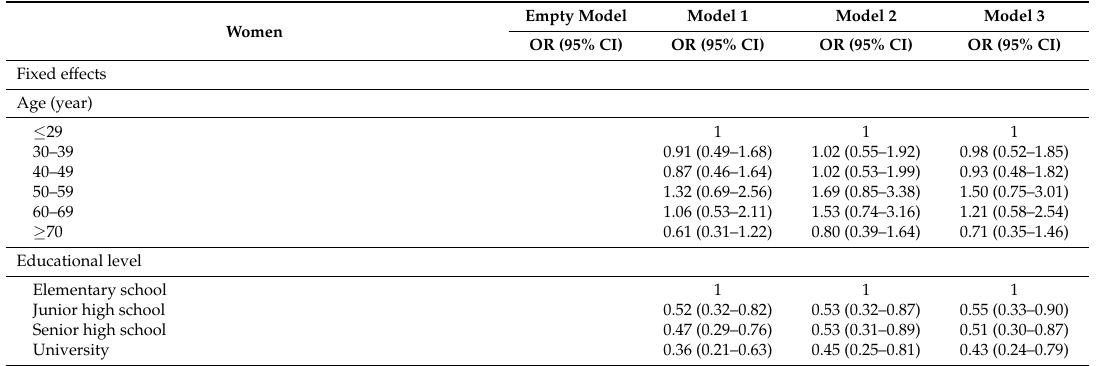
Table 3. The odds ratios and 95% confidence intervals for HD associated with individual and district-level social capital among